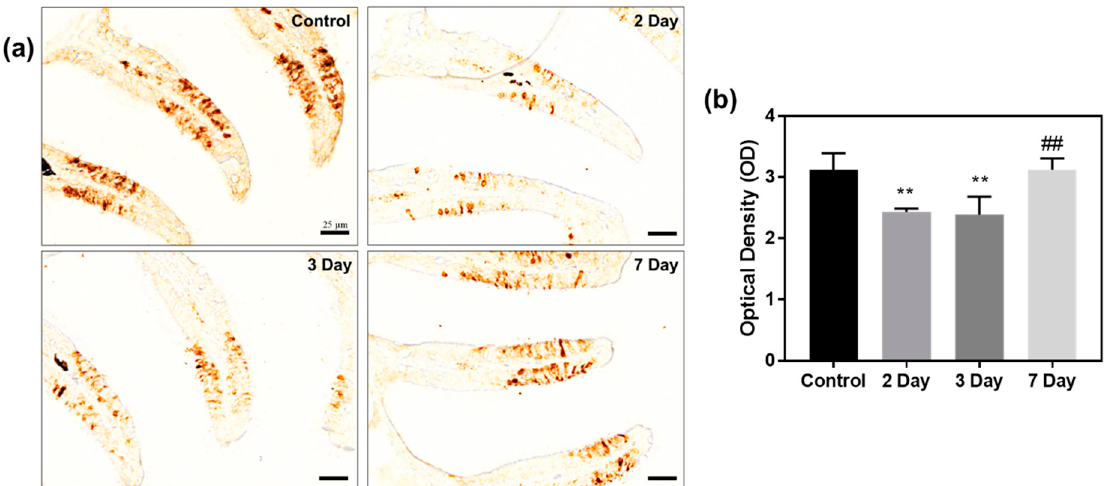
Figure 7. Immuno-histochemistry staining of anti-calretinin. ( a ) Images of anti-calretinin staining of control, damage group (2 and 3 days) and recovery group (7 days). Scale bar = 25 µm. ( b ) Graph of quantified calretinin intensity of optical density (OD) using image J 1.52a software. Values are re- ported as mean ± SEM of five distinct olfactory samples. Statistical analysis by one-way ANOVA, ** p < 0.01 versus control; ## p < 0.01 versus three-days.